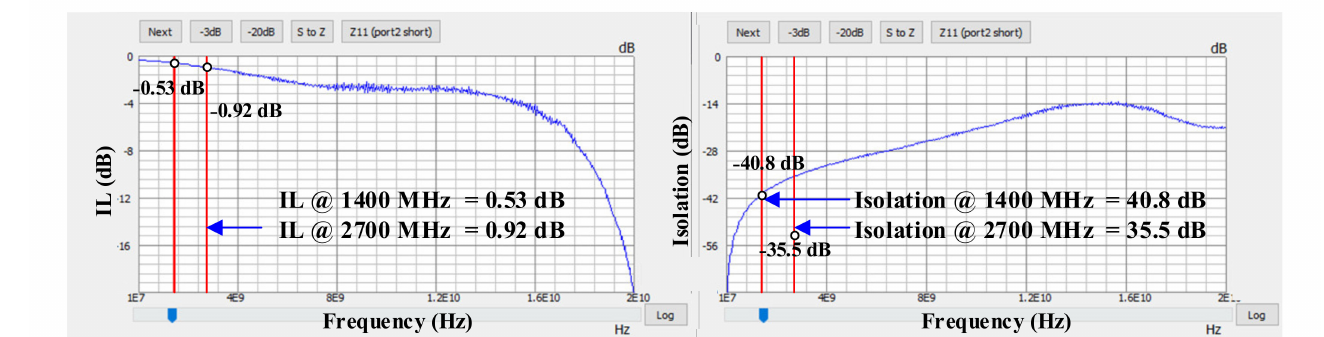
Figure 10. Measurement results of the S-Parameters for the mid and high bands from 1.4 GHz to 2.7 GHz.